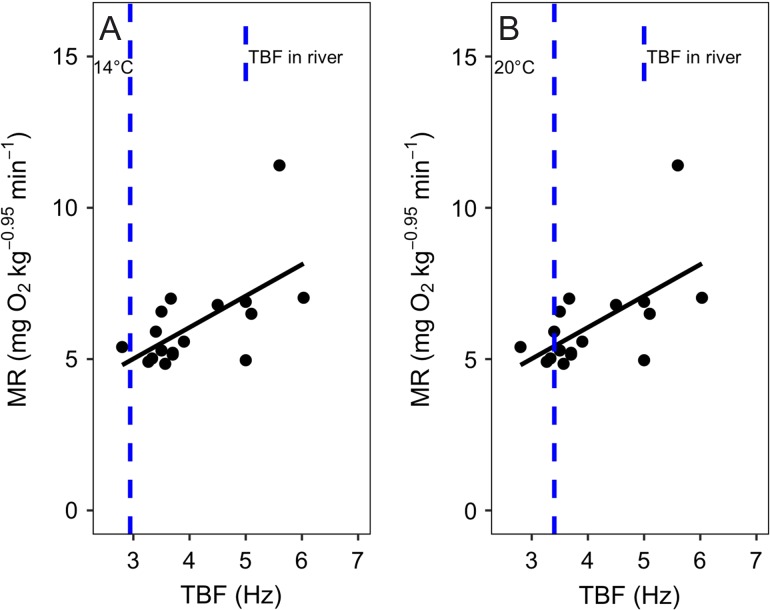
The relationship between tail beat frequency (TBF; in hertz) and metabolic rate (MR; in mg O2 kg−0.95 min−1) measured when Tuolumne River Oncorhynchus mykiss were swimming continuously in a swim tunnel at 14 (A) or 20°C (B). The continuous black line represents the linear regression based on the data for n = 7 fish at 14°C and n = 5 fish at 20°C. The vertical dashed lines represent the estimated TBF (2.94 Hz at 14°C and 3.40 Hz at 20°C) taken from videos of O. mykiss maintaining station in a water current in their normal Tuolumne River habitat. At 14°C, the relationship between TBF and MR followed the equation MR = 0.75TBF + 1.05, with degrees of freedom (d.f.) = 41, P < 0.001, residual standard error (RSE) = 1.27 and r2 = 0.35. According to this formula, the MR for the TBF measured in the river (2.943 Hz) at 14°C was estimated to be 3.26 mg O2 kg−0.95 min−1. At 20°C, the relationship between TBF and MR followed the equation MR = 1.04TBF + 1.89, with d.f. = 15, P = 0.009, RSE = 1.29 and r2 = 0.33. According to this formula, the MR for the TBF measured in the river at 20°C (3.402 Hz) was estimated to be 5.43 mg O2 kg−0.95 min−1.